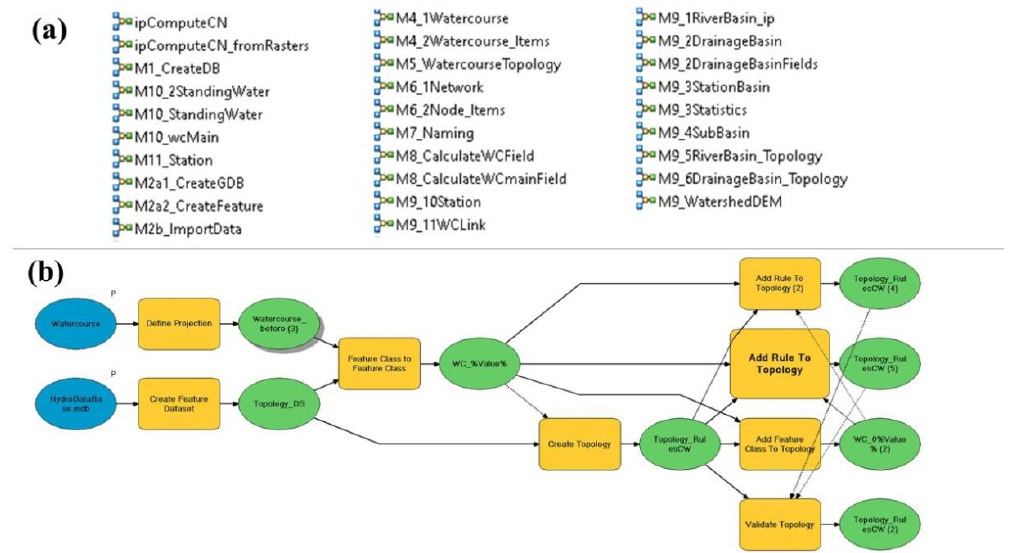
Figure 5. The OpenHiGis toolbox with the ( a ) list of containing models; ( b ) watercourse topology model of OpenHi.tbx.